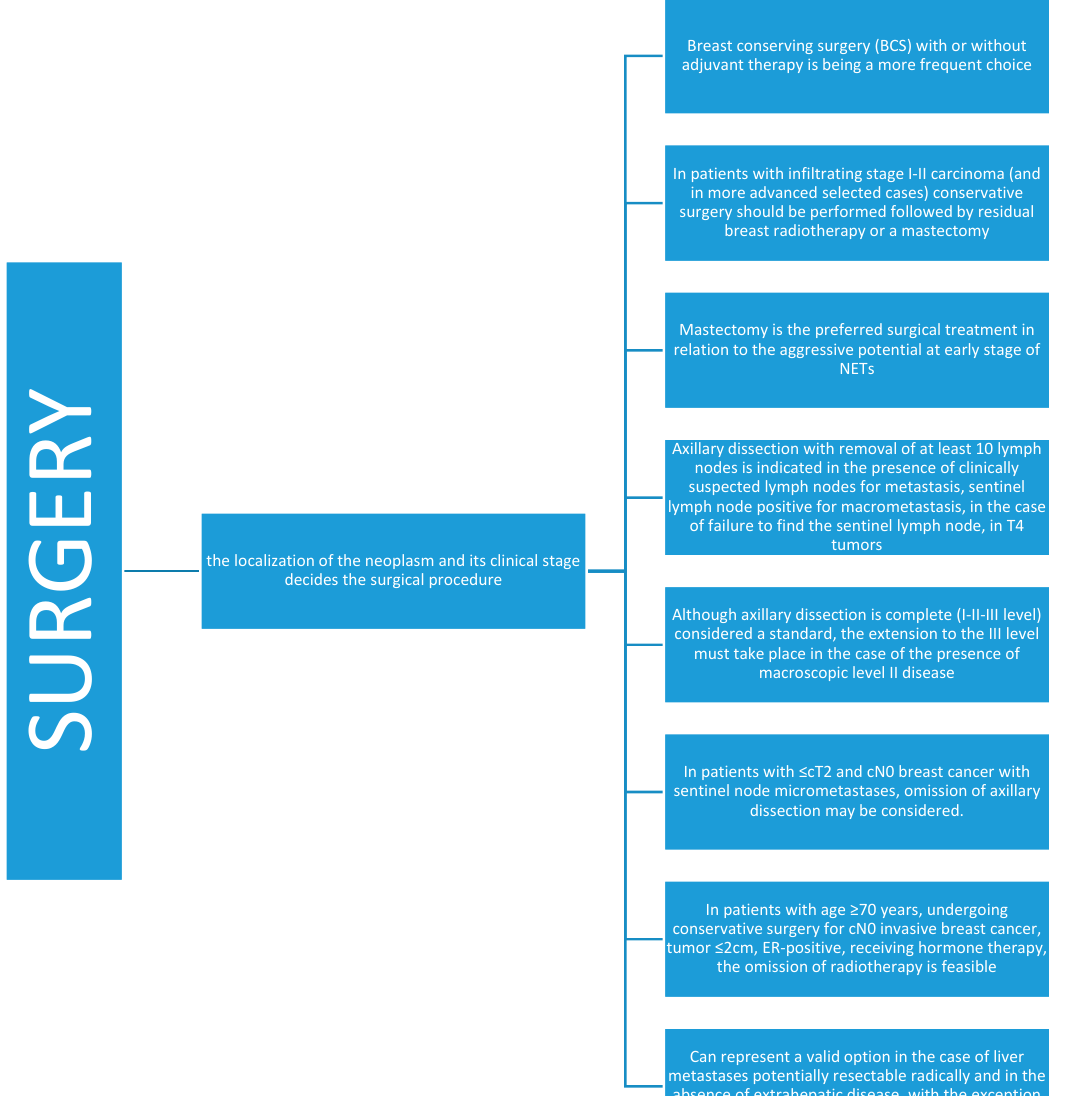
Figure 4. Surgery in neuroendocrine breast